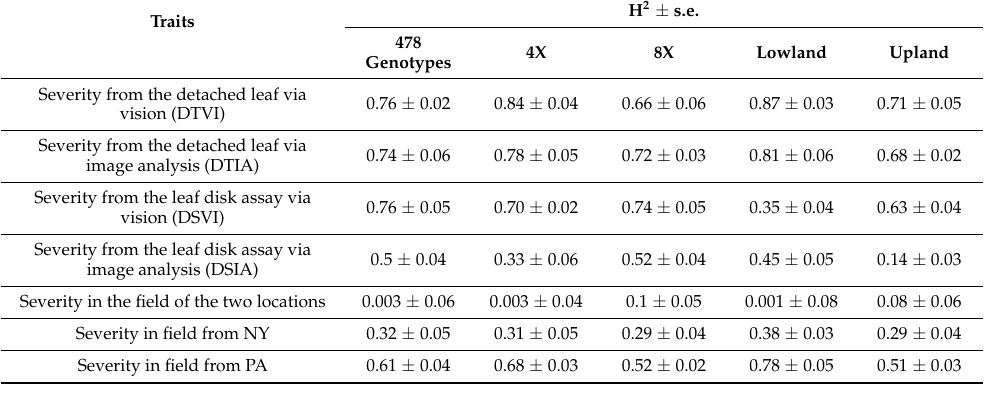
Table 1. Broad-sense heritability of each trait in each group. Traits